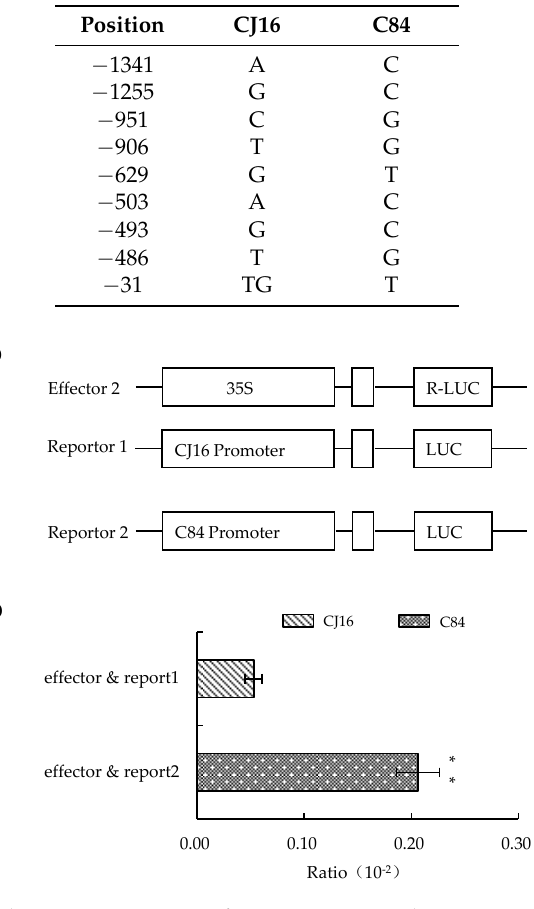
Figure 9. Comparison of the promoter activity of LOC_Os09g26999 between CJ16 and C84. ( a ) Diagram of carrier construction. ( b ) Ratio of promoter activity. Data are represented as mean ± SD ( n = 3). Asterisks represent significant difference determined by Student’s t -test at p -value <0.01 (**).